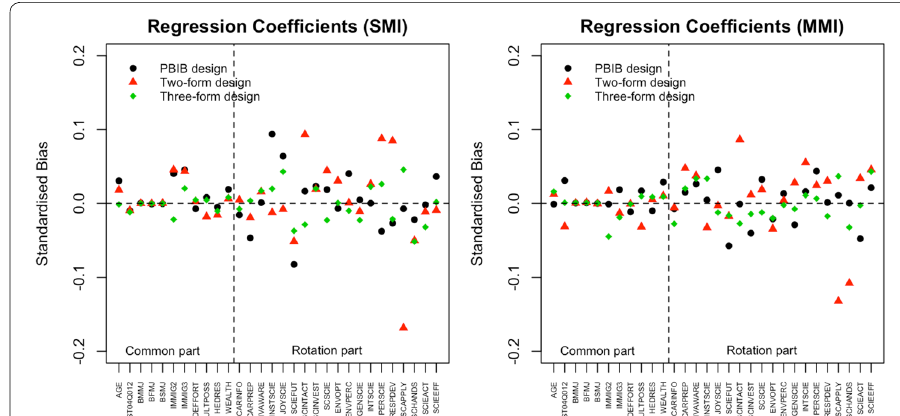
Fig. 5 Regression coefficient estimates under SMI and MMI approaches